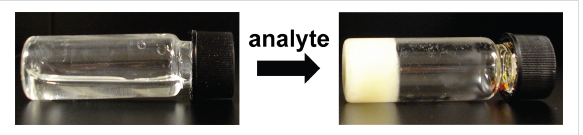
Figure 2: Sensing via analyte-triggered